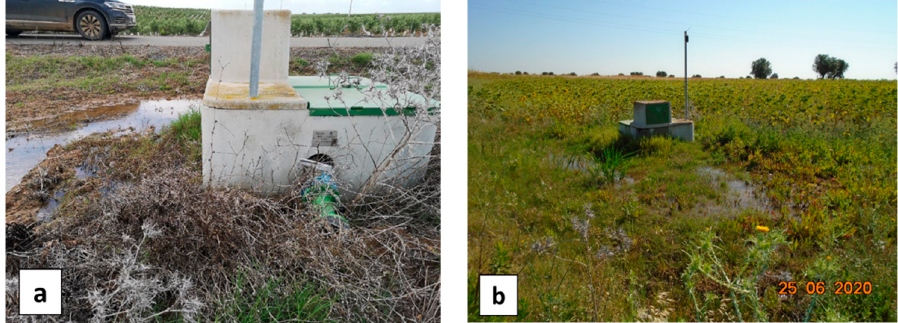
Figure 25. Pictures of hydrant H9.18 and surrounding vegetated ground taken on ( a ) 16 April 2020